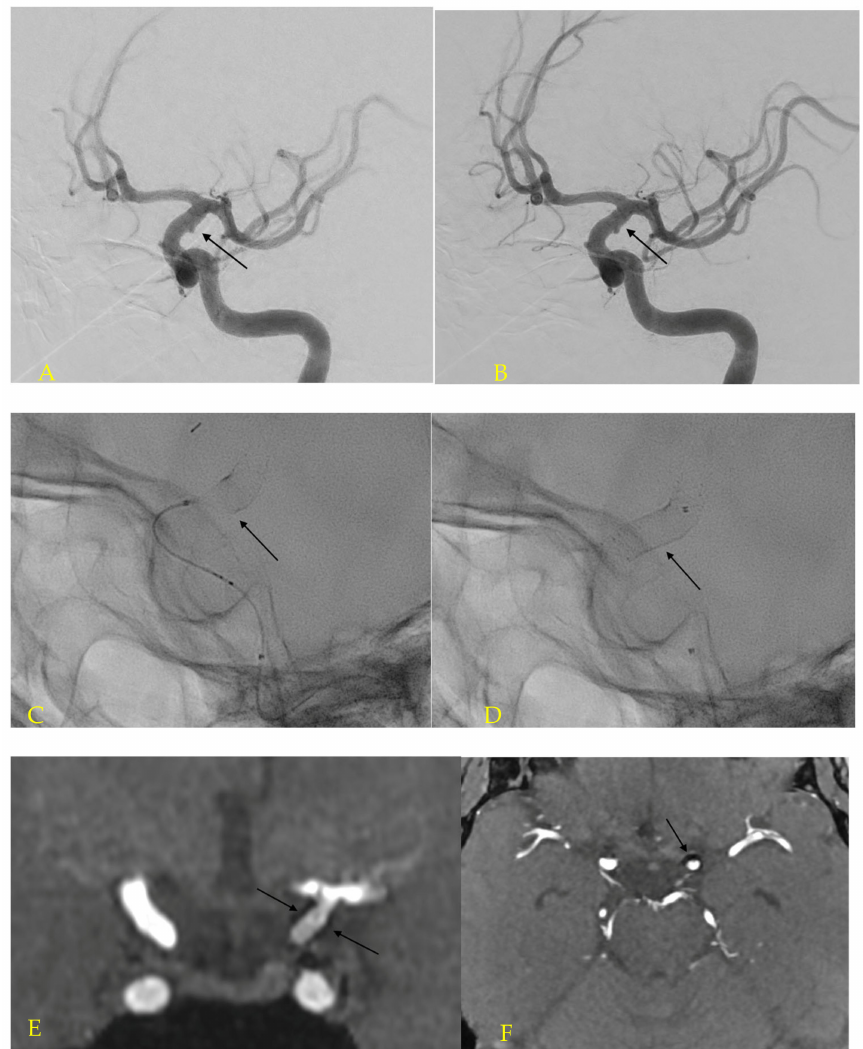
Figure 2. An oblique view of a left carotid artery angiogram revealed a tiny aneurysmal bulge in the supraclinoid segment of ICA ( A ), treated with the stent only and the post-procedural angiogram demonstrated filling the aneurysm ( B ). Fluoroscopic view during the stent positioning and implanta- tion ( C ), and post stent deployment with the microcatheter markers in the parent vessel ( D ). Coronal ( E ) and axial ( F ) views of the 1-year MR TOF follow-up shows full occlusion of the treated aneurysm and good visualization of stent wall